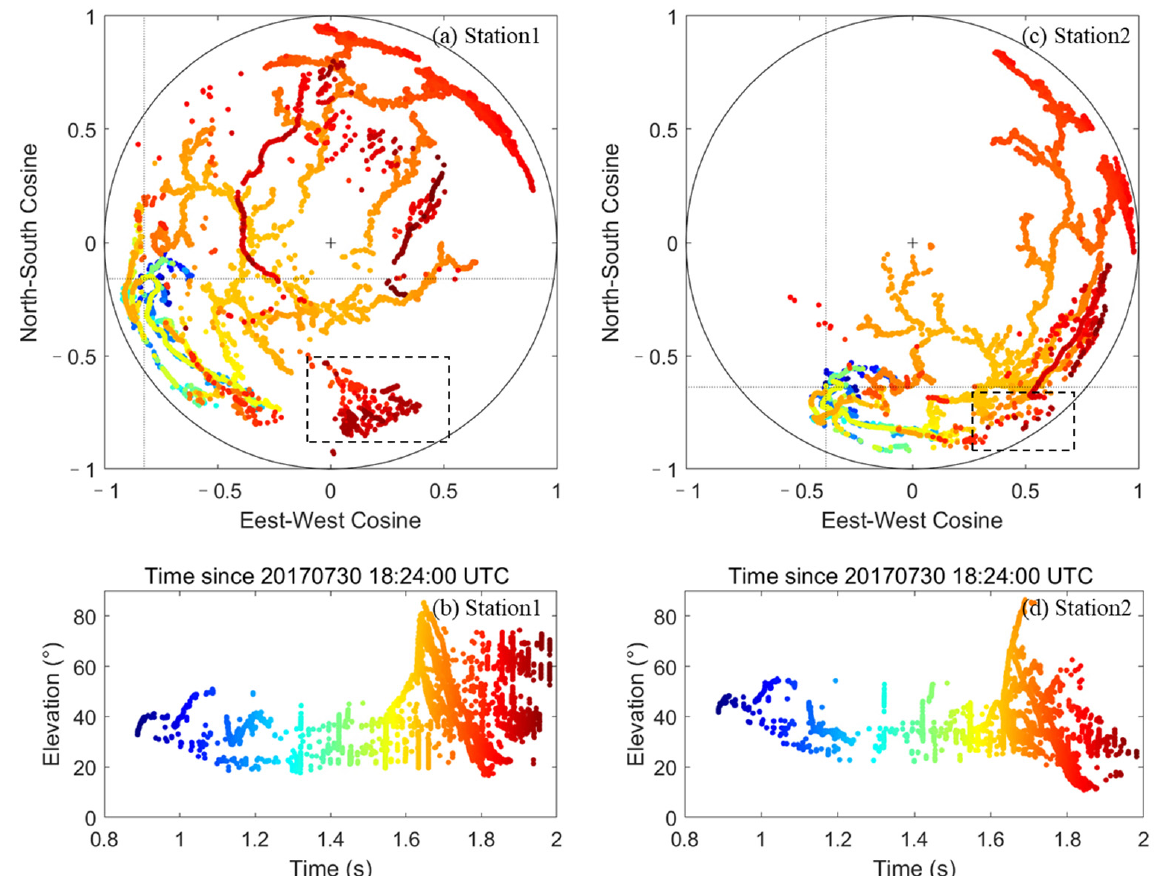
Figure 3. Two-dimensional mapping results of an intra-cloud lightning flash. Cosine projection ( a ) and elevation with time ( c ) observed by Station 1. ( b , d ) are the same as ( a , c ), but for Station 2. The white + shows the zenith of each interferometer, and the circle is the horizon. Dashed lines intersect at the origin of the flash.